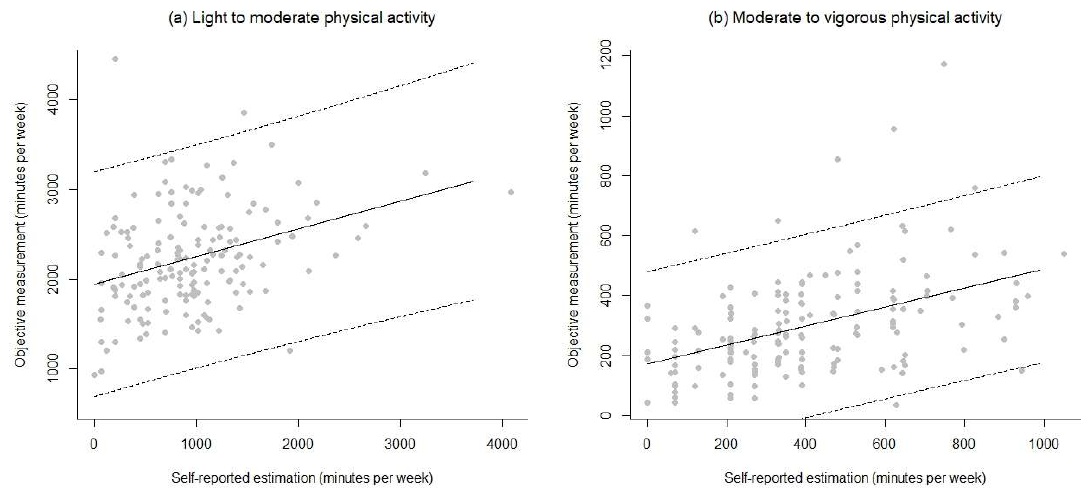
Figure 3. Regression models’ residuals for LMPA and MVPA (self-reported and objective) for the second trimester of pregnancy.